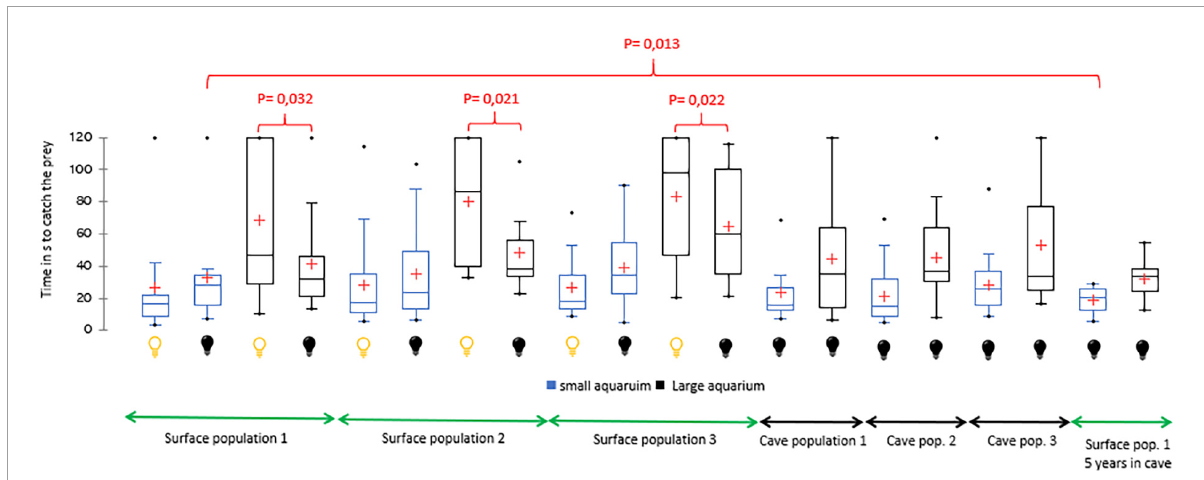
FIGURE1 Time (in seconds) to prey capture by individuals ( N = 20) from surface and cave populations in the small aquarium (4.5 L), large aquarium (22.5 L), in light conditions ( ), and darkness ( ). The red crosses represent the means. The central horizontal bars represent the medians. The lower and upper limits of the box represent the first and third quartiles, respectively. The minimum is shown at the far bottom of the whisker, and the maximum is shown at the far top. P-values are indicated when